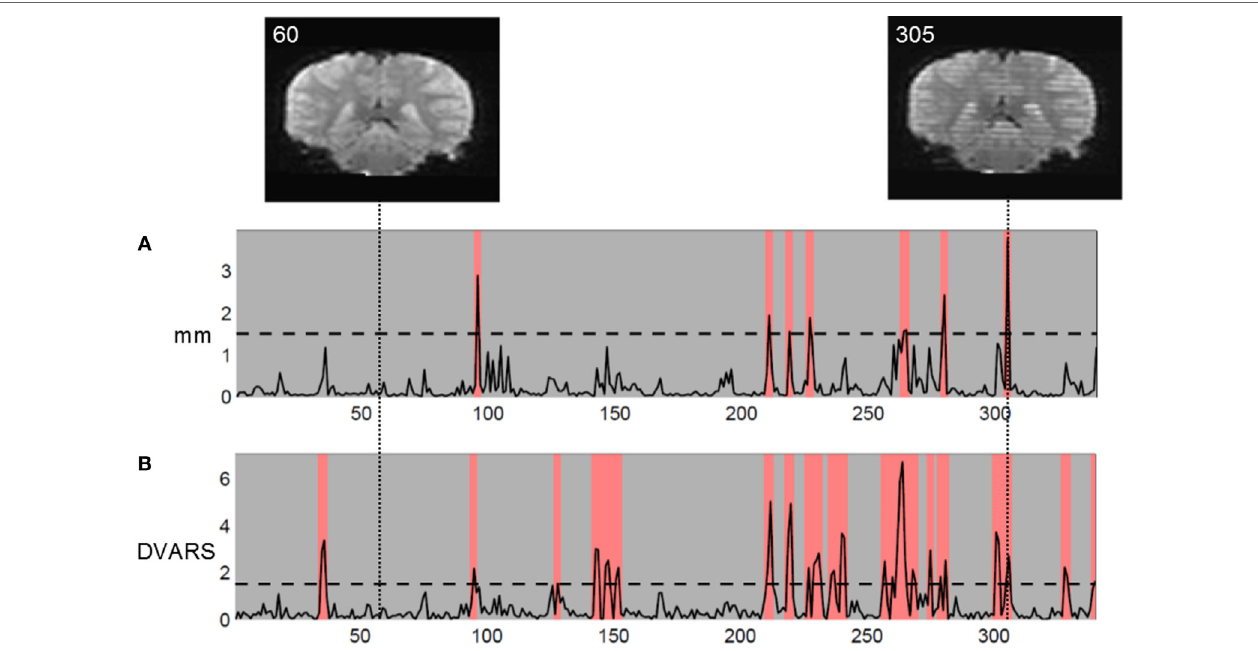
FiGURe 1 | Coronal reconstruction of echo planar images (ePi) in volume without motion (volume 60, left) and volume with motion artifacts (volume 305, right) . The striped appearance of volume 305 arises from the interleaved EPI sequence used. Two movement measures are shown: (A) Euclidian translational displacement in millimeter and (B) DVARS (percent mean signal change) as defined in Ref. (5). In this study of children, with liberal chosen movement thresholds, we discarded volumes exceeding threshold and marked in